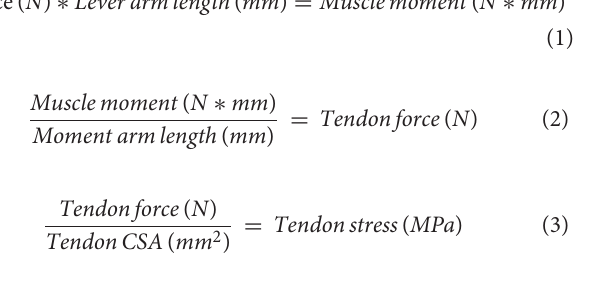
Lepley et al., 2018) and instantaneous CSA (Smart et al., 2017,